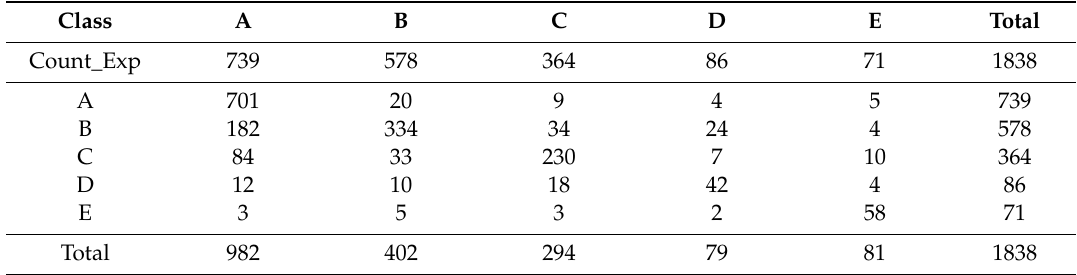
Table 6. The confusion matrices of bu ff er based analyzing for crown-based ITC SVM (Count_Exp: Count of Experiments, A–E are